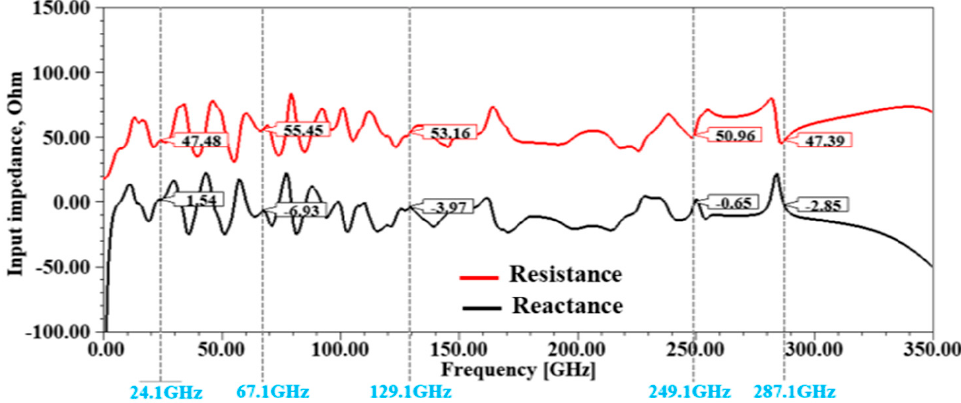
Figure 5. Simulated input impedance of designed antenna: real and imaginary part. Table 3. Input impedance of proposed antenna at selected resonant frequencies.